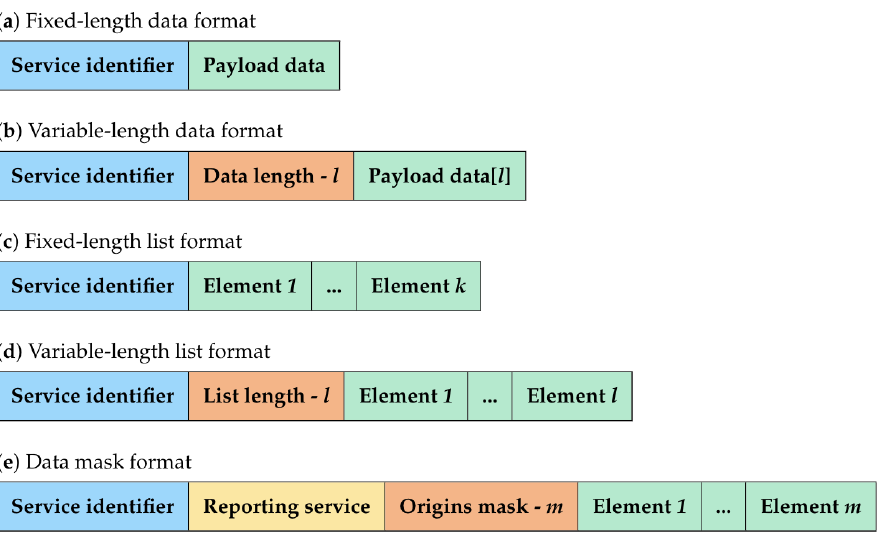
Figure 1. Service message formats.